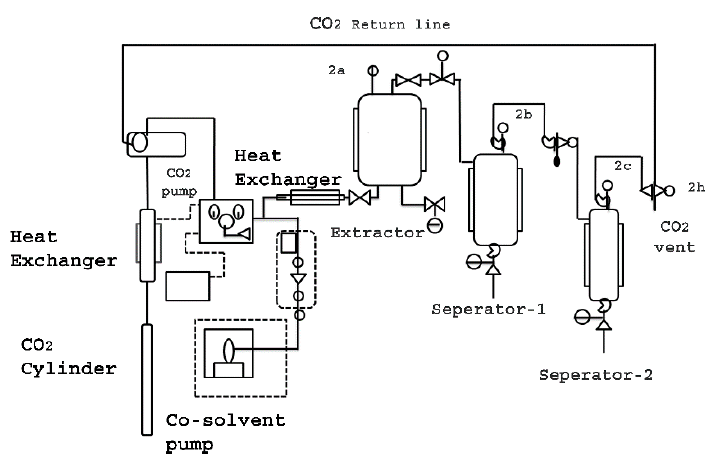
Figure 1. Schematic diagram showing Supercritical Fluid Extractor (2a, 2b, 2c, and 2h are the pressure valves).